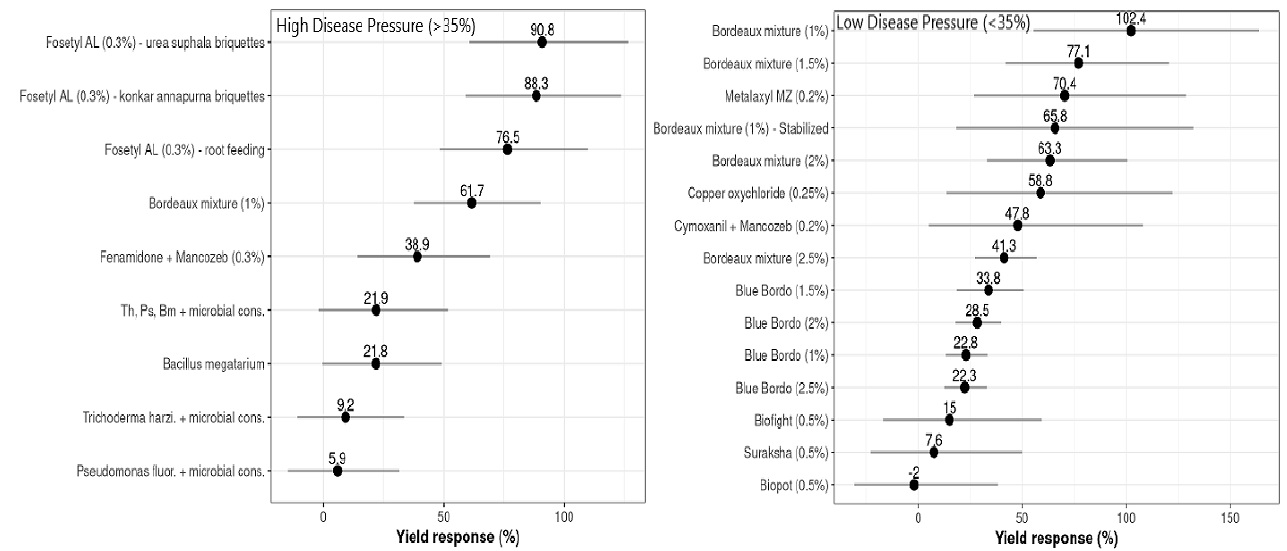
Figure 5. Yield differences ( D , points) and 95% confidence intervals (horizontal lines) for each eval- uated treatment used to control FRD in arecanut at both disease baseline classes (low ≤ 35%, high > 35%). These values were estimated by fitting the network meta-analysis model in R